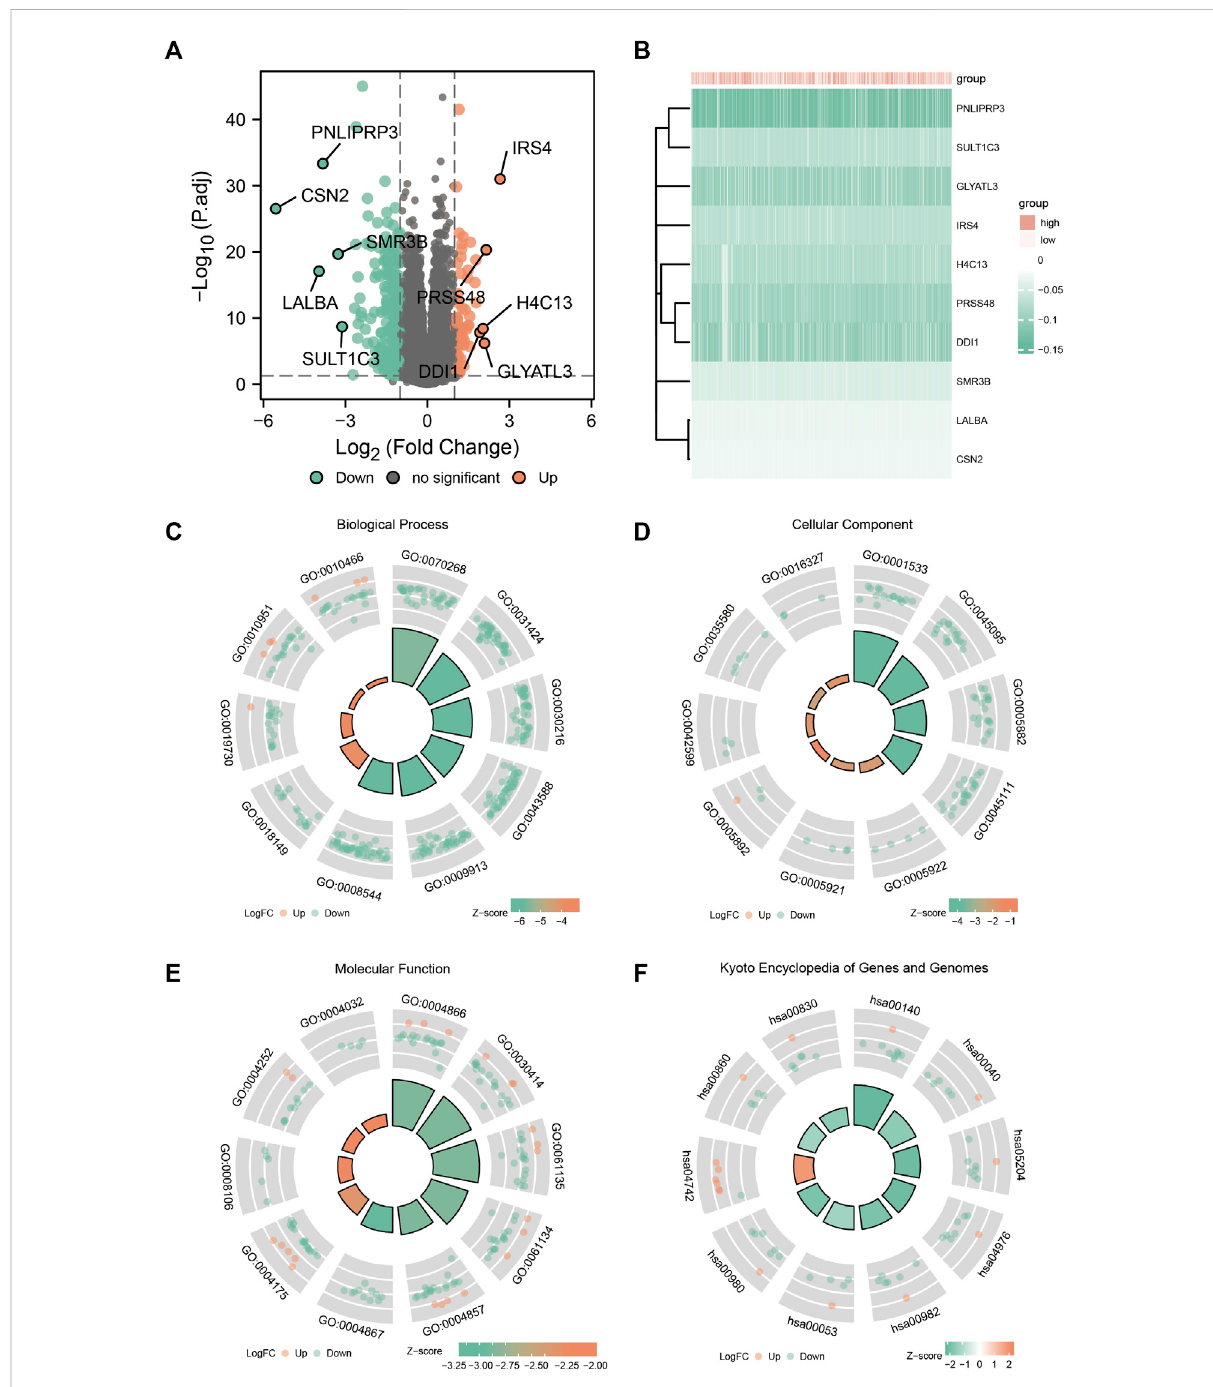
FIGURE 3 Enrichment analysis of GO and KEGG. (A) Volcanic plot of differentially expressed genes in the high- SYCP2 expression group and the low- SYCP2 expression group. (B) Heatmaps of the top fi ve differentially expressed genes in high- and low- SYCP2 expression groups. (C) Biological process, BP. (D) Cellular component, CC. (E) Molecular function, MF. (F) Kyoto Encyclopedia of Genes and Genomes,